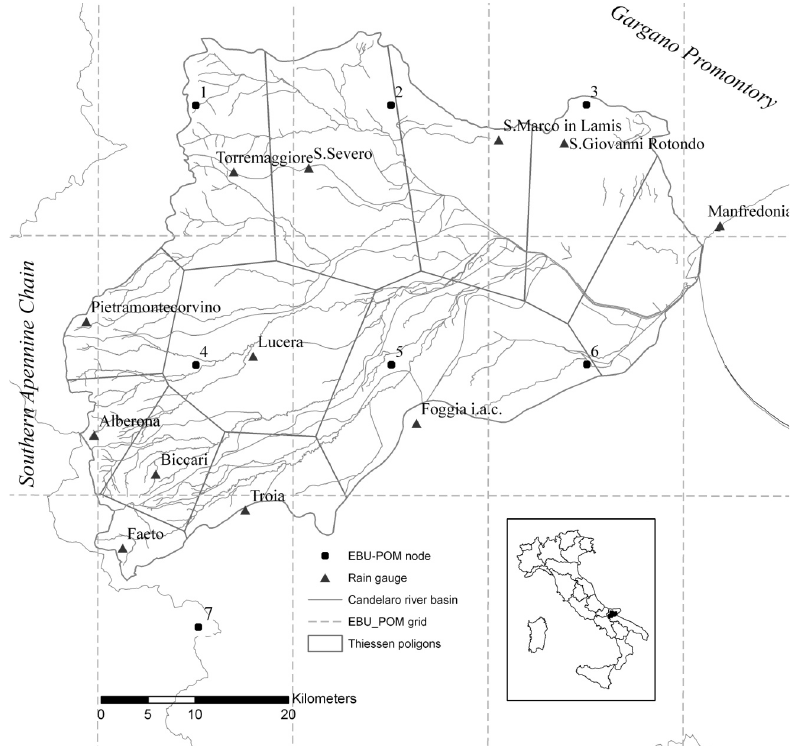
Fig. 1. The rainfall network in the Candelaro river basin and the corresponding RCM